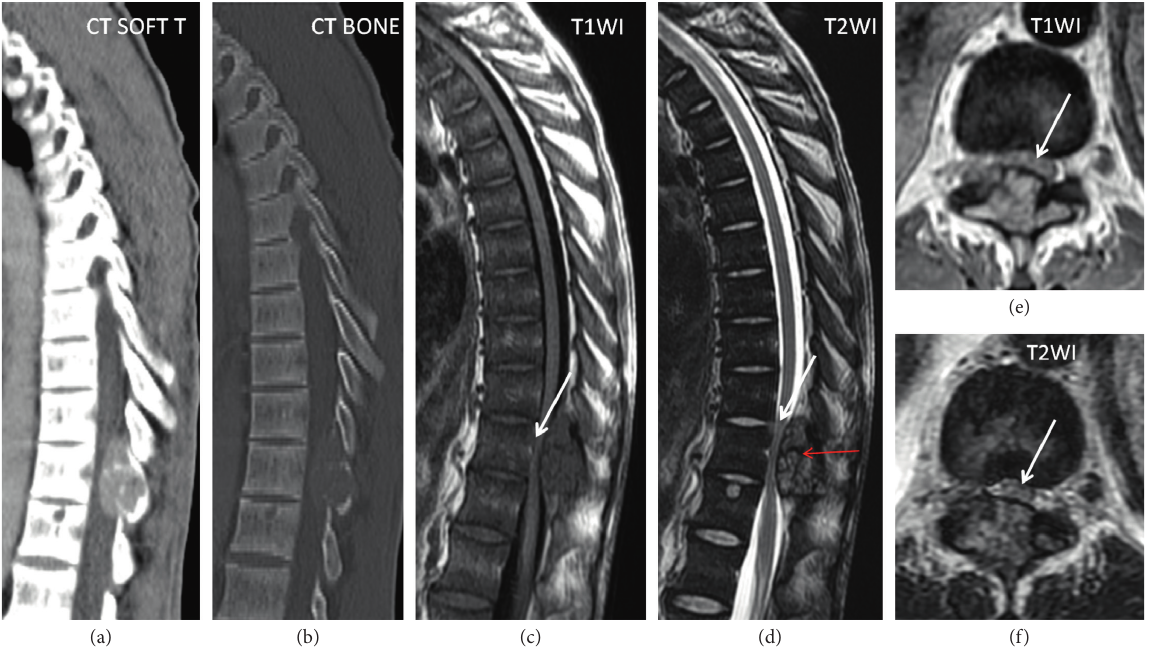
Figure 7: Thoracic spine brown tumor. Sagittal CT, sagittal T1WI/T2WI, and axial T1WI/T2WI MRI sequences show an expansible, well- circumscribed lesion in the posterior elements extending within the spinal canal, with severe spinal canal stenosis and compressed spinal cord (white arrow). Areas of low signal on T2W1 from hemosiderin are indicated by the red